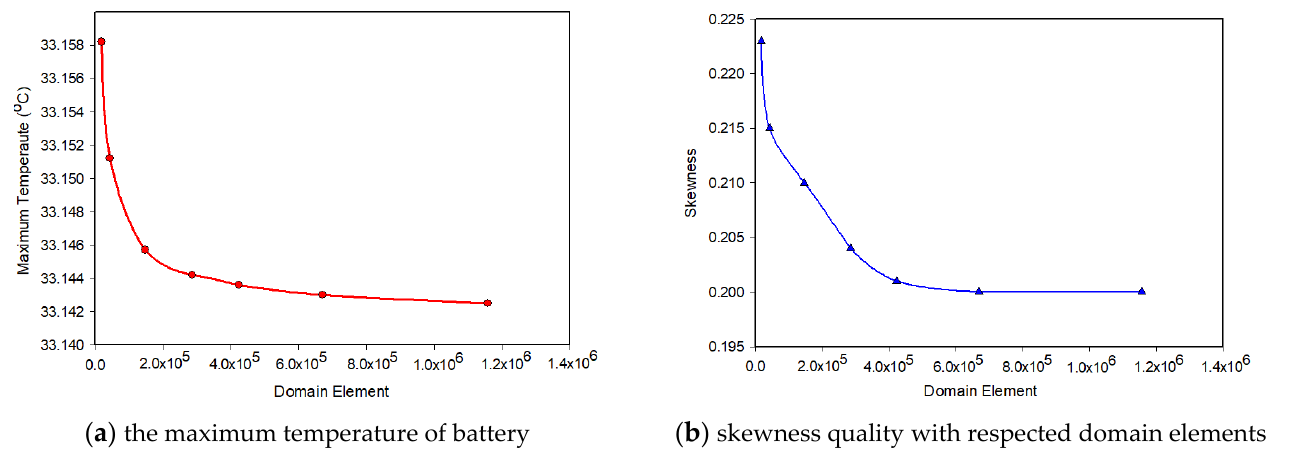
Figure 10. The mesh sensitivity study of NMC cylindrical cell ( a ) the calculated results of maximum temperature, and ( b ) skewness quality with respected domain elements. Table 2. Domain elements for simulation model.